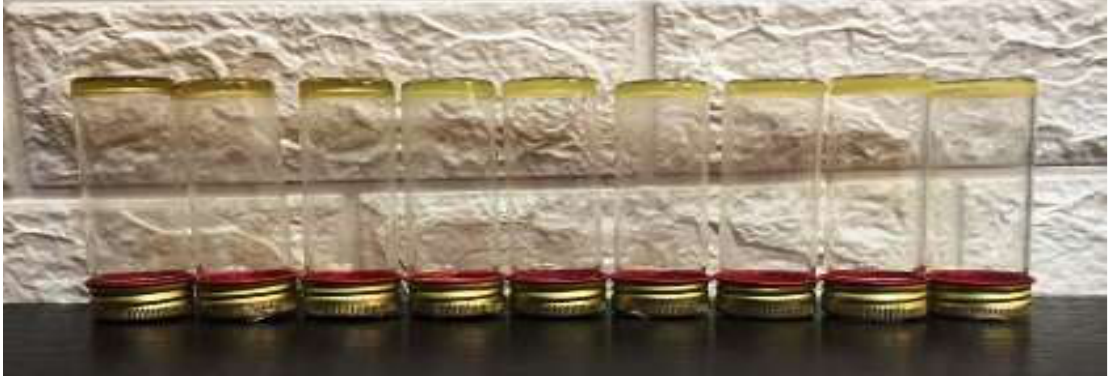
Figure 1.Inverted vials of HOA in SO at room temperature from left to right the organogel formulations (F1, F2, F3, F4, F5, F6, F7, F8,